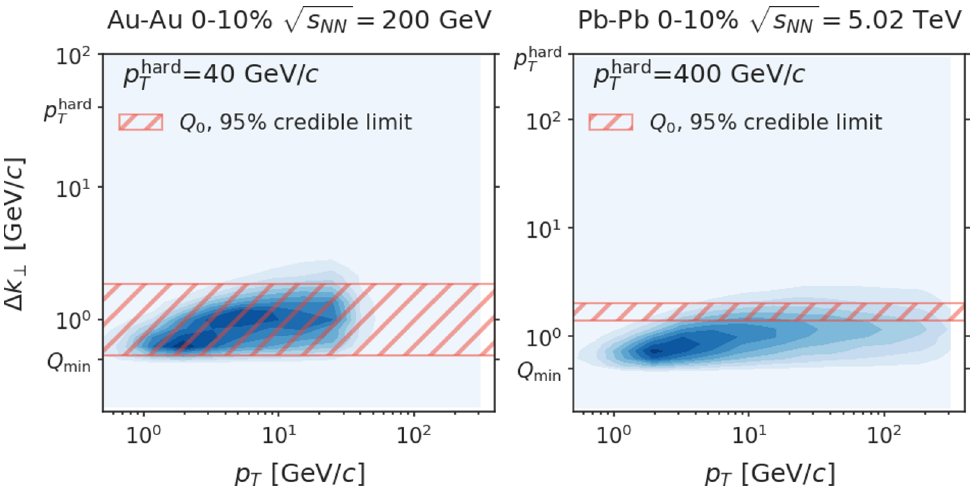
Figure 4 . Comparing the calibrated Q 0 parameters to momentum broadening distributions ob- tained in